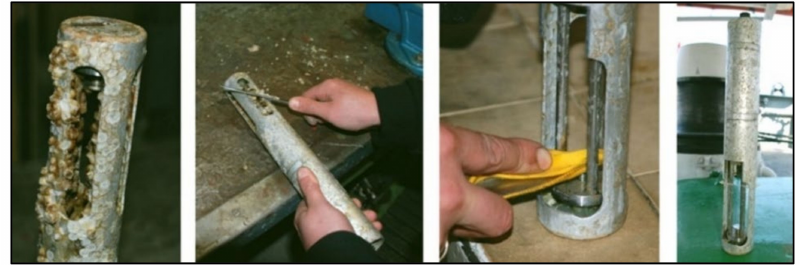
Figure 14. Cleaning the sound velocity sensor after disassembly by a